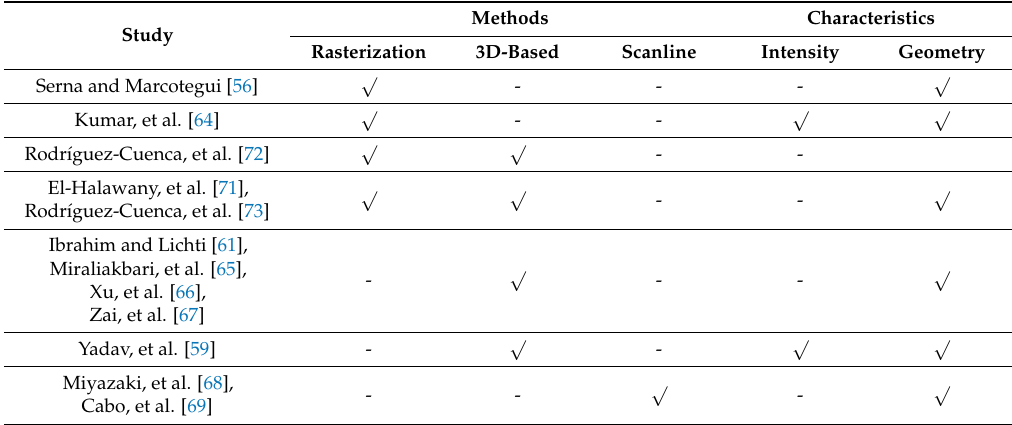
Table 4. Summary of method for road boundary